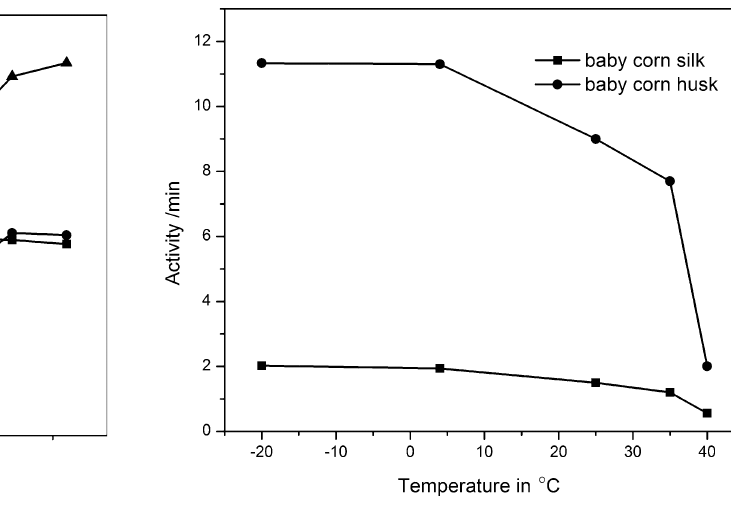
Fig. 5 Optimization of temperature for bay corn silk and